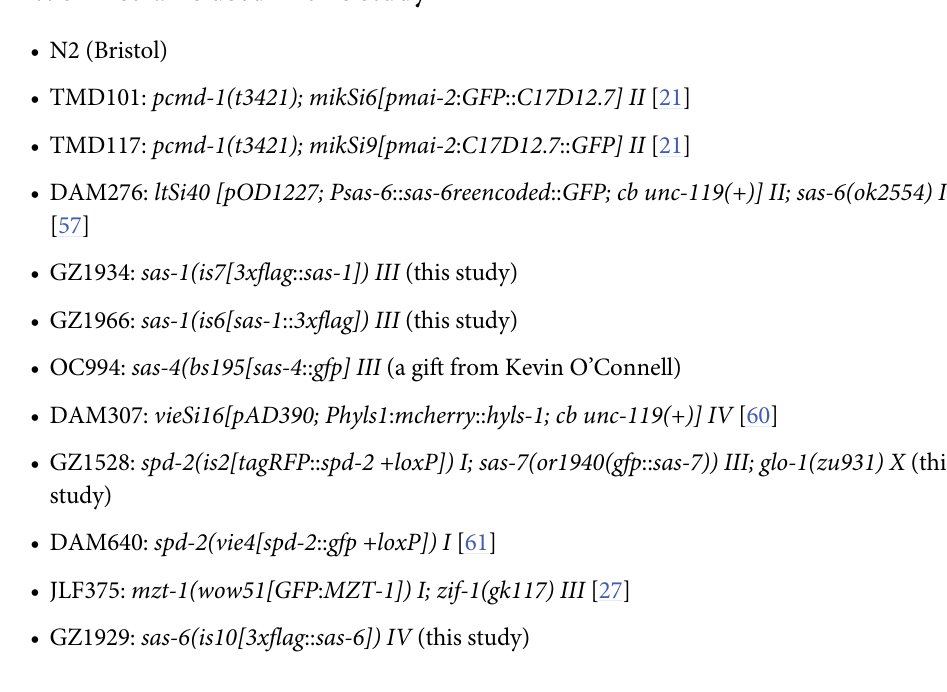
S1 Fig. Procentriole composition and maturation. (A) Widefield image of 2 pairs of centri- ole/procentriole in an S-phase cell located in the mitotic zone of the gonad after U-Ex, stained for SAS-6 and α -tubulin. Note that procentrioles harbor SAS-6 but no α -tubulin at this stage. (B) U-Ex-STED images of centrioles from the mitotic zone (left and middle) and meiotic pro- phase (right). Images illustrate that the amount of ZYG-1 on the centriole (but not on the pro- centriole) varies: During meiotic prophase, ZYG-1 levels on the centriole are very low. For quantification, a line was drawn from the center of the centriole to the outside of the procen- triole and the intensity profile along this line measured, as represented by the dashed arrows. (Left and middle) In the mitotic zone, whereas 12/25 centrioles exhibited a similar distribution to that observed in the vast majority of meiotic prophase centrioles (see right), 13/25 displayed the ZYG-1 signal more prominently than during meiotic prophase, with 2 clear ZYG-1 peaks, one at the base of the procentriole and one in the middle of the centriolar SAS-6::GFP signal. (Right) In 95% of meiotic prophase centrioles (19/20), a single ZYG-1 signal intensity peak was detected outside of the centriole peak, directly under the procentriole. (C) 3D-SIM sum intensity Z-projected image of a nucleus in the mitotic zone of an expanded gonad. Phosphor- ylated Histone 3 marks nuclei in mitosis. Insets on the right show that all 4 centrioles contain α -tubulin, unlike in S or G2 phase. SIM, Structured Illumination Microscopy; U-Ex-STED, Ultrastructure Expansion coupled with STimulated Emission Depletion. S2 Fig. Schematic of 9-fold symmetrization process. Images of centrioles seen from the top were centered in a square ROI, then cropped and iteratively rotated by 40˚ (left). The resulting nine images were arranged in a stack and sum intensity projected (middle). The resulting image represents a 9-fold symmetrized image